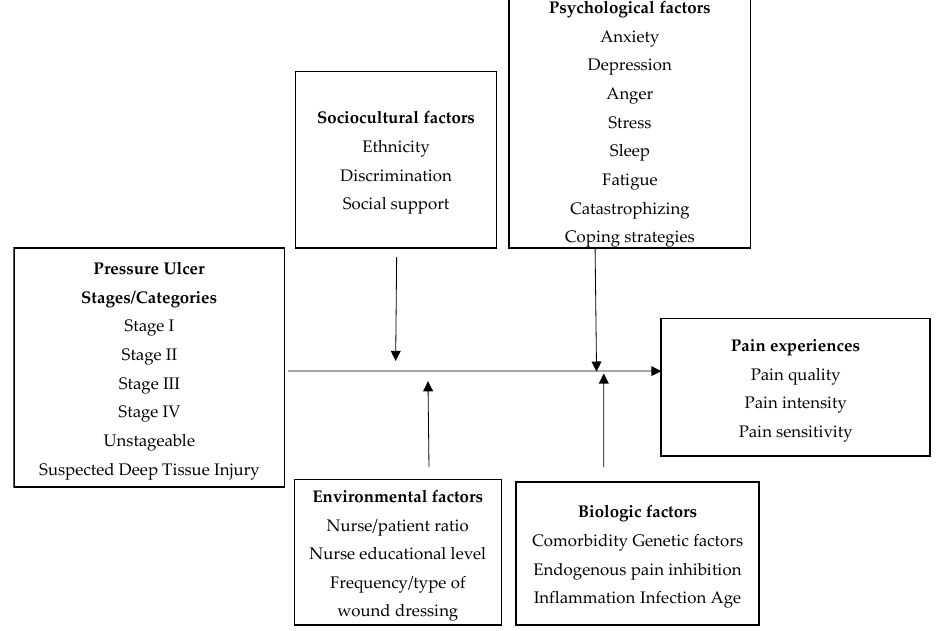
Figure 2. The Proposed Conceptual Framework. Table 1. Factors and components of the proposed model.